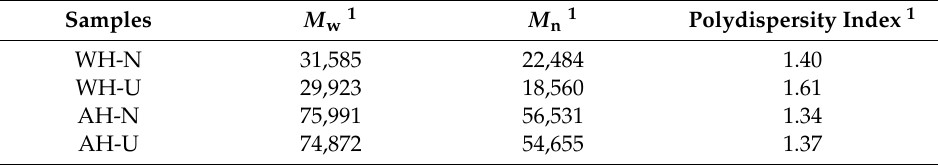
Table 5. M w , M n , and polydispersity of